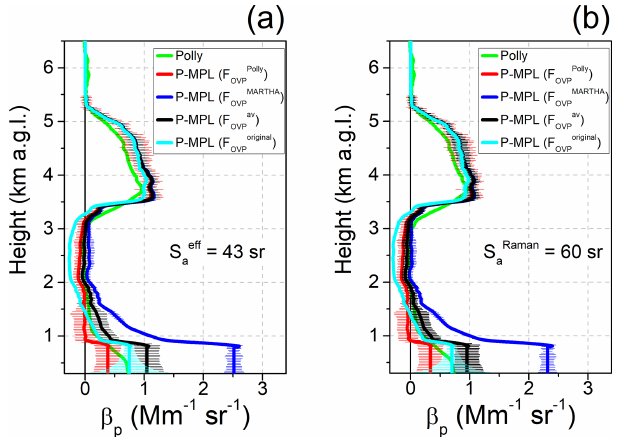
Figure 5. Dust case observed on 29 June 2019 at 20:00–21:00UT over Leipzig. Vertical particle backscatter coefficient (PBC), β p , as retrieved by using the particular OVP function applied to the P-MPL RCS: F OVP with respect to Polly (red) and MARTHA (blue) data and both the F av (black) and F original (cyan) using the KF so- OVP OVP lution with (a) the elastic AOD-constrained LR ( S eff a = 43sr), and (b) the Raman-retrieved LR ( S Raman a = 60sr) for the dust layer. Corresponding Polly-retrieved β p profiles are also included (green